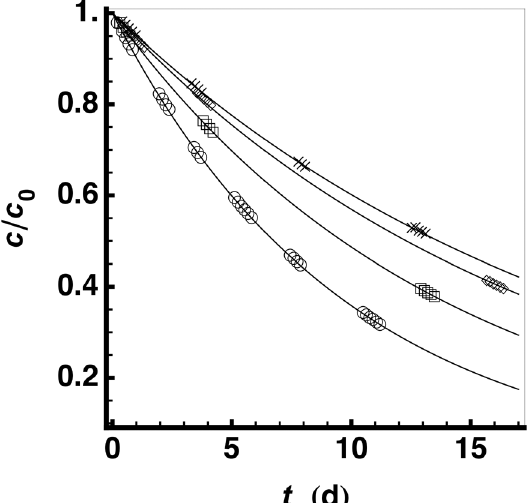
Fig 4. Esterase activity at pH 4.3 measured by NMR. The relative concentration of substrate measured by 1D- 1 H NMR peak intensities is shown as a function of reaction time for: ( (cid:3) ) 40 μ M of 21 ; ( □ ) 40 μ M of 12 and; ( (cid:1) ) co-aggregate of 20 μ M of 12 with 20 μ M of 21 ; (×) buffer control (50 mM d 3 -NaOAc at pH 4.3 and 2% d 6 - DMSO). Only 1 in 12 data points are shown to avoid overcrowded plot markers.